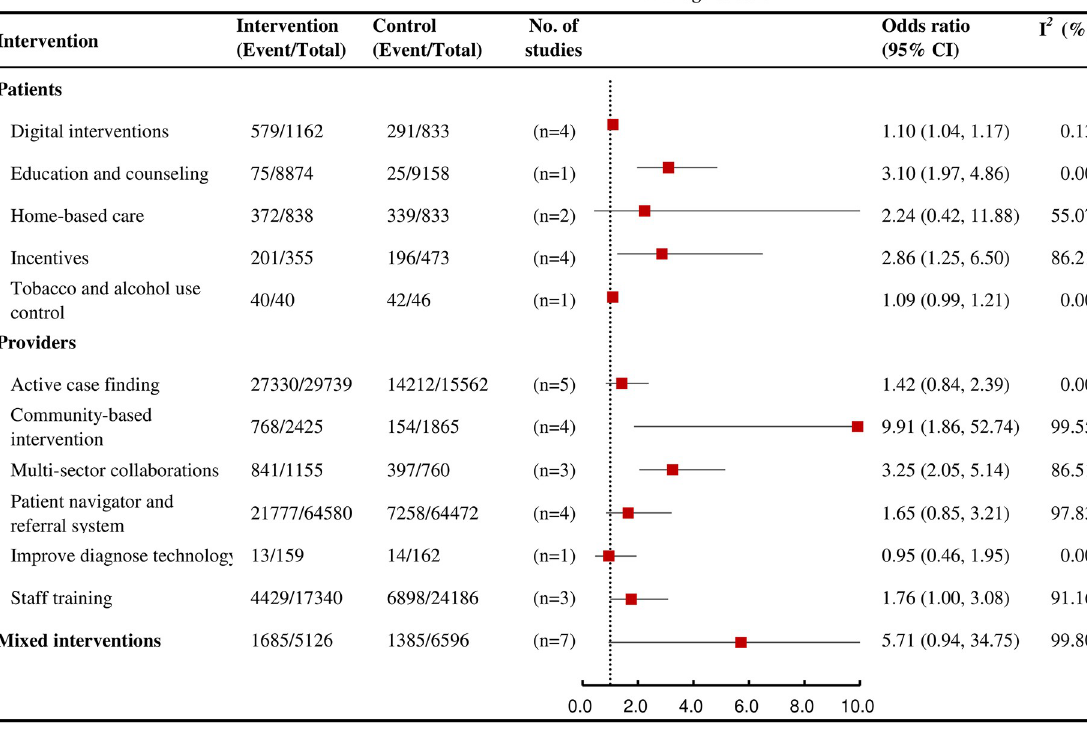
PLOS Medicine| https://doi.org/10.1371/journal.pmed.1004091 January 3,